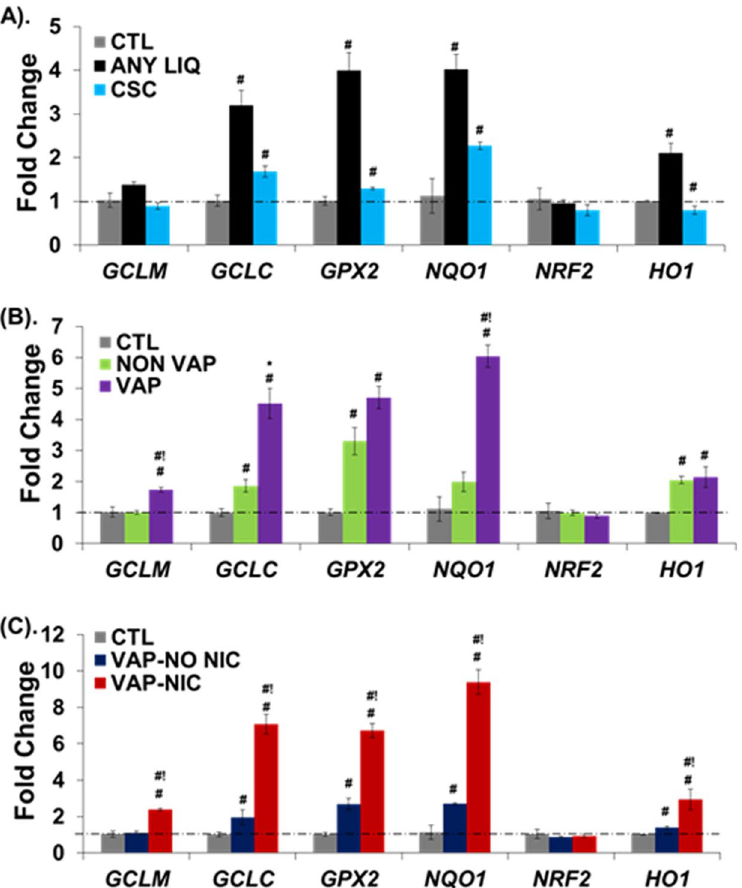
Figure 2. Expression of oxidative stress (OxS) response genes in NHBE cells upon eCig exposure. eCig liquid exposure induces OxS response gene expression in primary human lung epithelial cells. NHBE cells were treated for 2 days with CSC (40 µ g), or with 2% non-vaporized (NON VAP) or vaporized and condensed (VAP) eCig liquid, lacking (NO NIC) or containing nicotine (NIC). Following treatment for 48 hours, cells were tested for mRNA expression of OxS genes using qPCR. ( A ) Treatment of cells with any eCig liquid, vaporized or not, with or without nicotine (ANY LIQ) induced the expression of GCLC , GPX2 , NQO1 , and HO1 . Attenuated responses were observed for CSC. ( B ) Vaporized and condensed eCig liquid (VAP) displayed a larger response than non-vaporized eCig liquid (NON VAP) on OxS mRNA expression. Treatment of cells with VAP significantly induced the expression of GCLM , GCLC , GPX2 , NQO1 and HO1 compared to CTL. Expression of GCLM , NQO1 and GCLC were further increased in VAP treatment compared to NON VAP treated cells. ( C ) Nicotine containing eCig vapor induced the maximal OxS response among all exposure conditions. VAP with no nicotine (VAP-NO NIC) modestly induced the expression of GCLC , GPX2 , NQO1 and HO1 compared to CTL. Conversely, VAP with nicotine (VAP-NIC) induced the expression of GCLM , GCLC , GPX2 , NQO1 and HO1 compared to CTL. # p < 0.05 (vs CTL); #! p < 0.05 (NON VAP vs VAP or VAP-NO NIC vs VAP-NIC) (MWU). * p < 0.09 (NON VAP vs VAP)